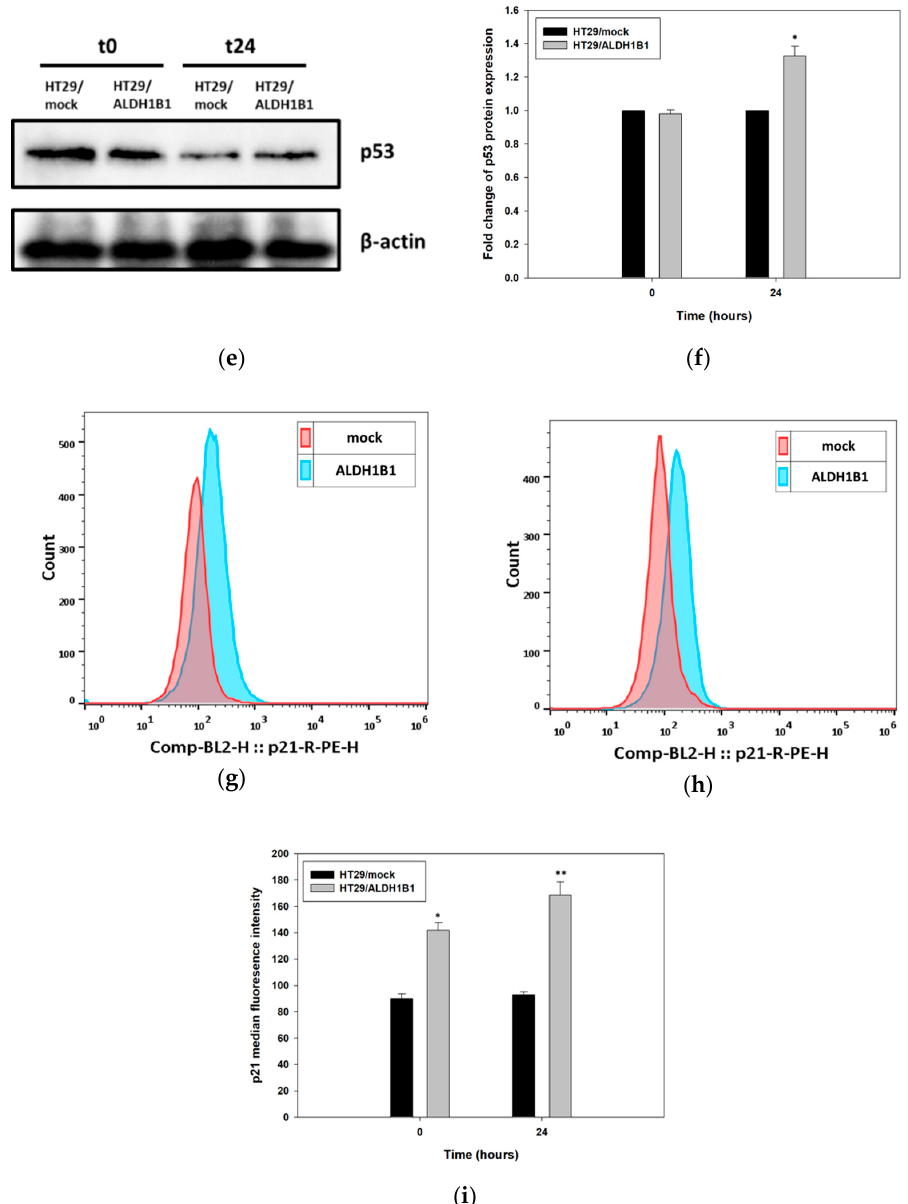
Figure 4. ALDH1B1 induces G2/M cell cycle arrest 24 h post-synchronization through p53-dependent upregulation. ( a – d ) Cell cycle kinetics in the HT29 isogenic cell line pair. Cells were synchronized in the G0/G1 phase (starvation, 24 h), and cell cycle kinetics were analyzed at the indicated time points. Approximately, 20% more HT29/ALDH1B1 cells were found in the G2/M phase 24 h post-synchronization compared to HT29/mock cells. The upregulation of p53 (>1.3-fold higher than HT29/mock cells) 24 h post-synchronization ( e , f ) led to p21 upregulation in ALDH1B1-overexpressing cells ( g – i ). The ALDH1B1 histogram (light blue color) had appreciably right-shifted at the time of synchronization ( g ) and 24 h post-synchronization ( h ) in comparison with HT29/mock cells (pink color), indicating the increased p21 expression levels in ALDH1B1-overexpressing cells. At least 20,000 events were analyzed through flow cytometry, and the median fluorescence intensity for p21 was determined in both cell lines (Table 4). Equal protein loading was verified by stripping and re-probing the same membranes with β -actin ( e ). The above graphs are representative of an experiment. At least three independent experiments were performed for each condition. * p < 0.05 and ** p < 0.01.